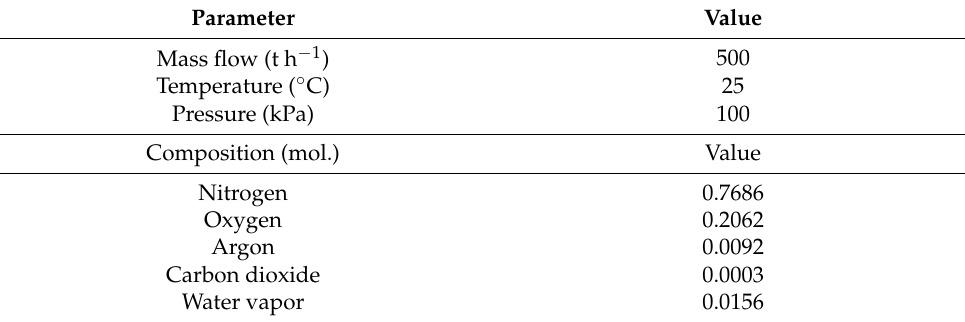
Table A1. Inlet air parameters and composition [36].